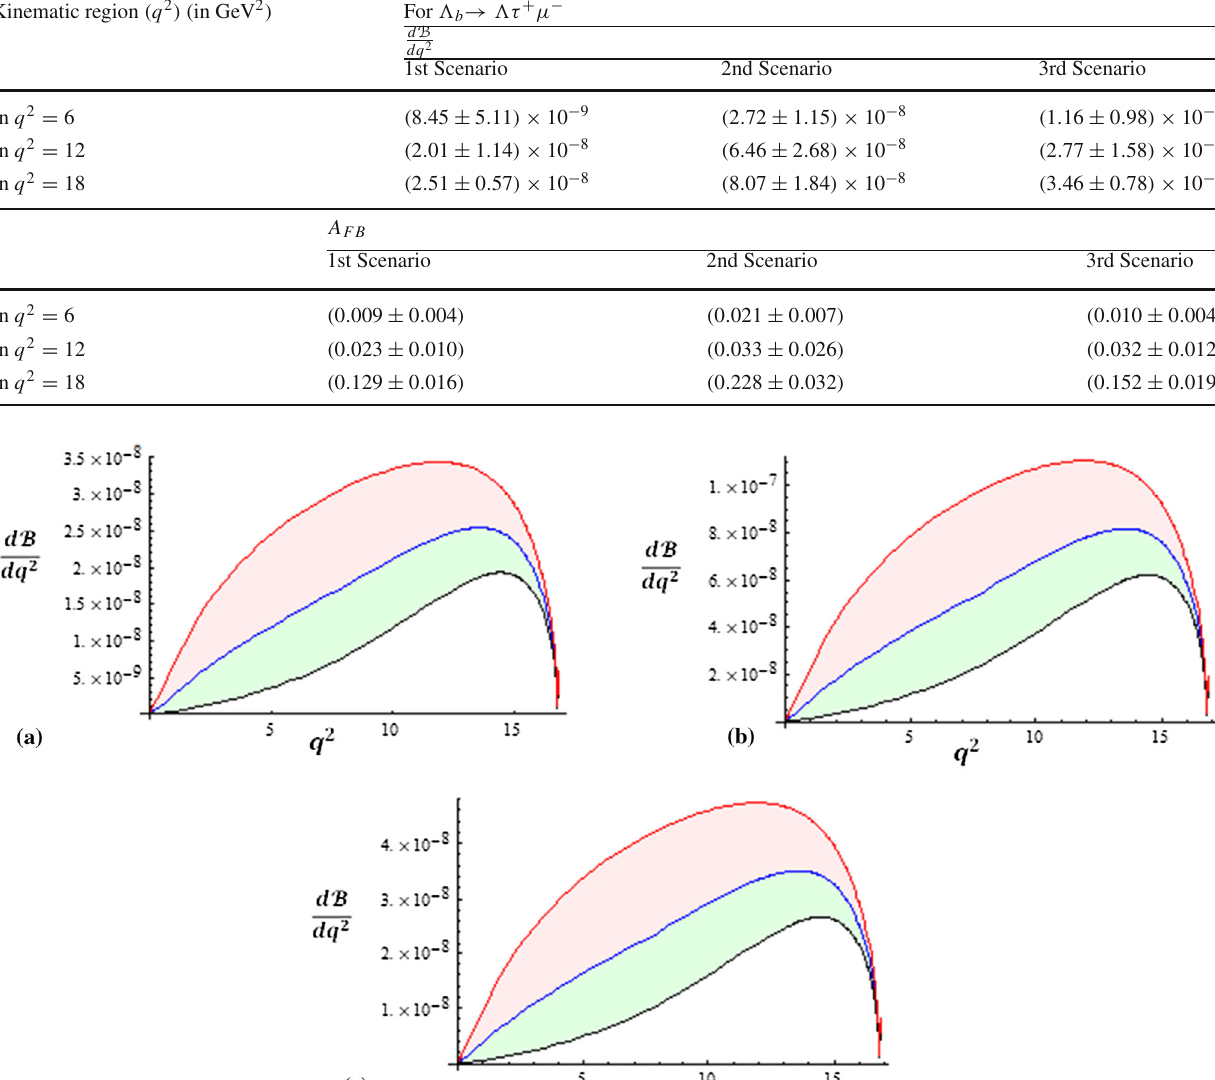
branching ratio and A FB for (cid:2) b → (cid:2)τ + μ − decay are